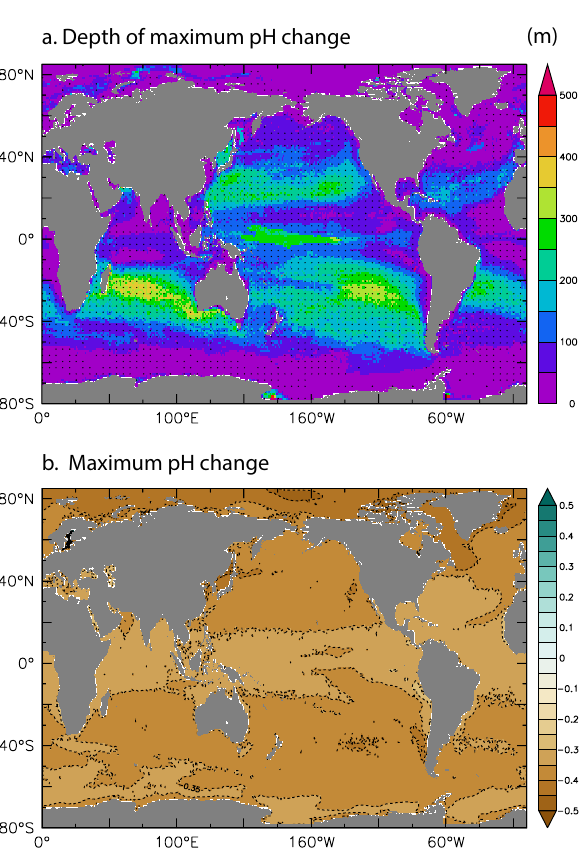
Fig. 8. Change in pH in 2090–2099 relative to 1990–1999 under RCP8.5. (a) Model-mean depth of the maximum changes in pH. Robustness estimated from inter-model standard deviation and (b) model-mean changes of pH at that